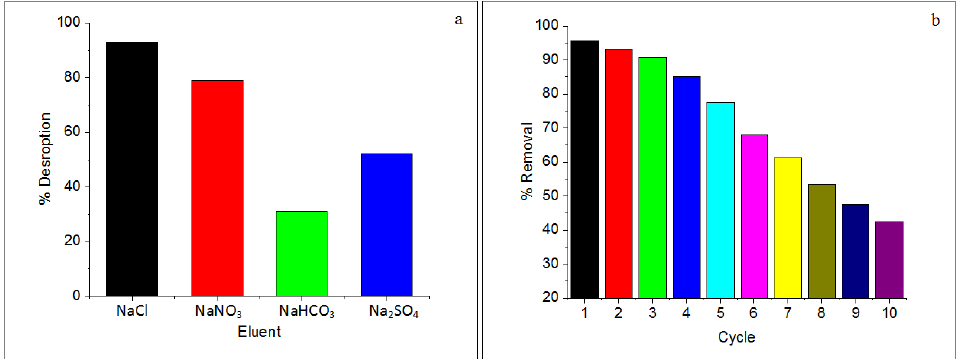
Figure 9. ( a ) Desorption Studies and ( b ) adsorption – desorption